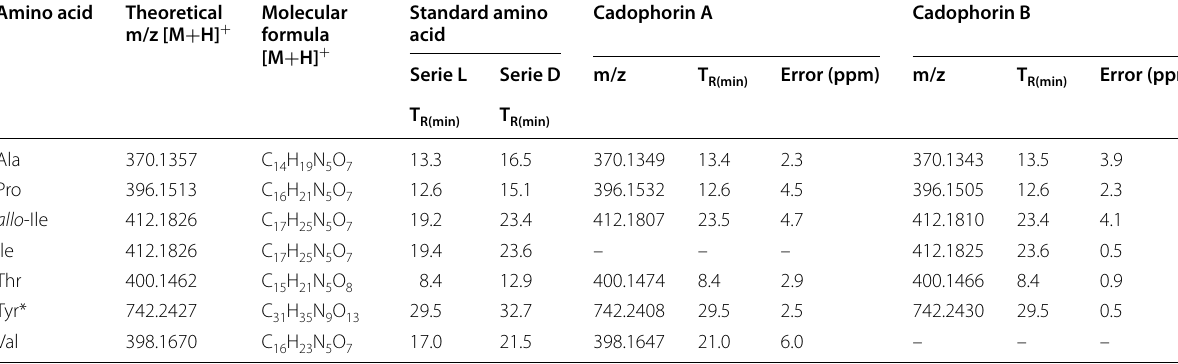
) of amino acid l -FDVA T